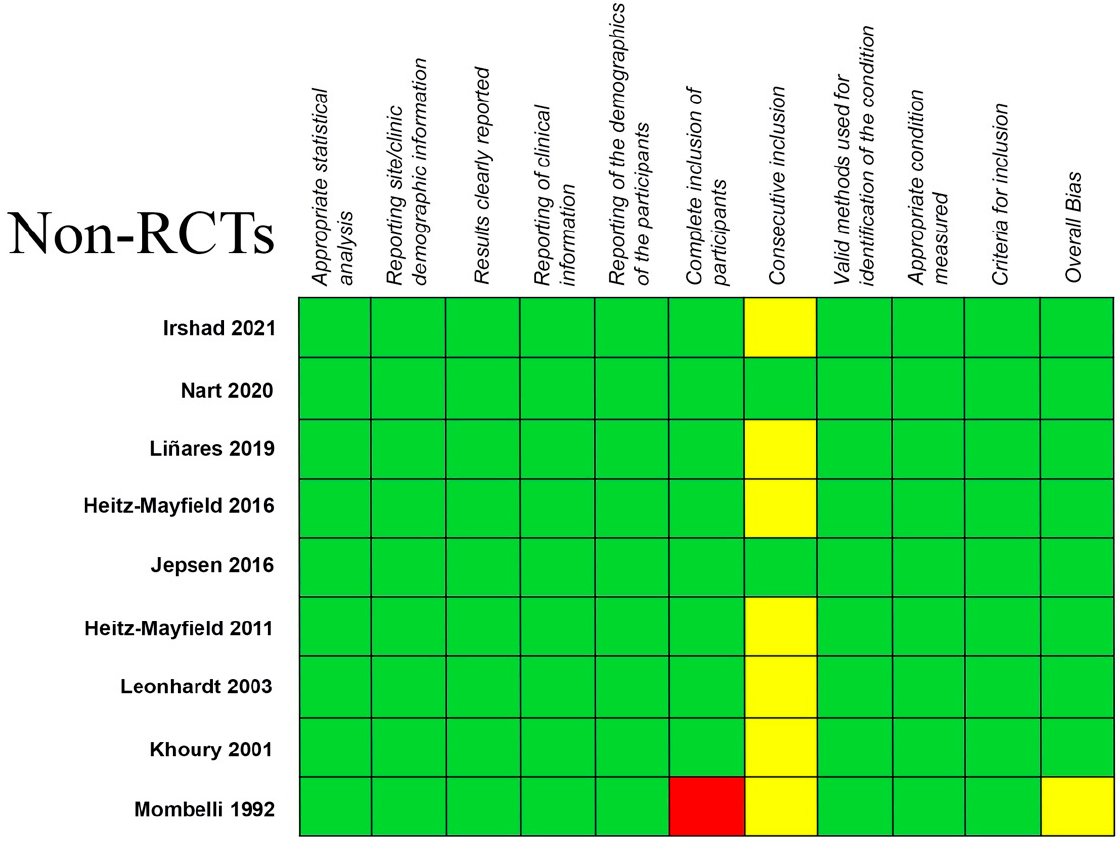
Figure 3. Quality evaluation of the non-RCTs using The Joanna Briggs Institute Critical Appraisal tool. The risk of bias of the included studies was contemplated as low (green), unclear (yellow) or high (red)